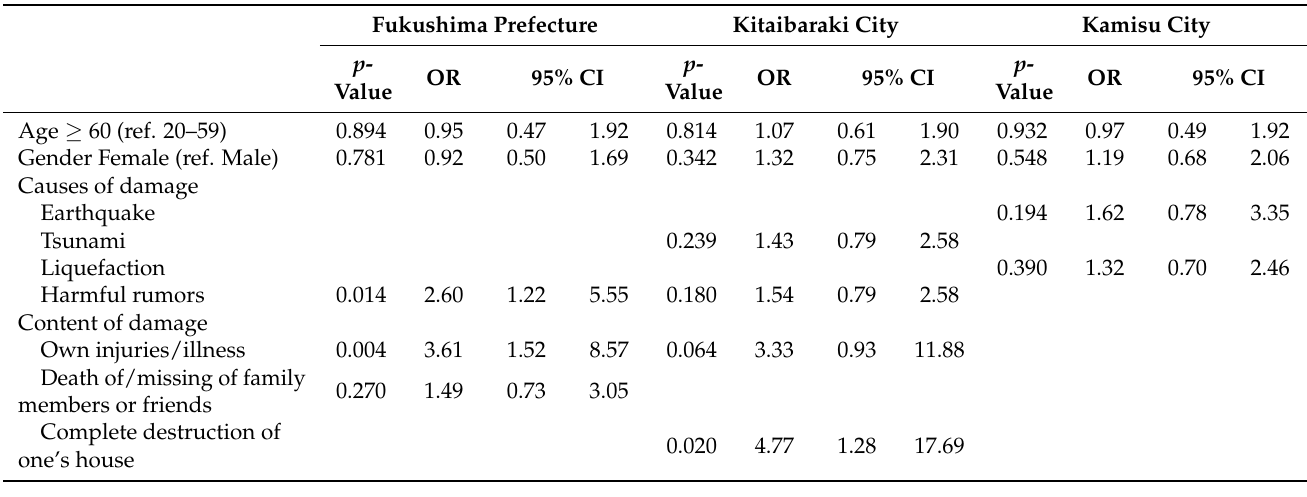
Table 5. Logistic regression analysis of characteristics of the participants and post-traumatic stress symptoms.